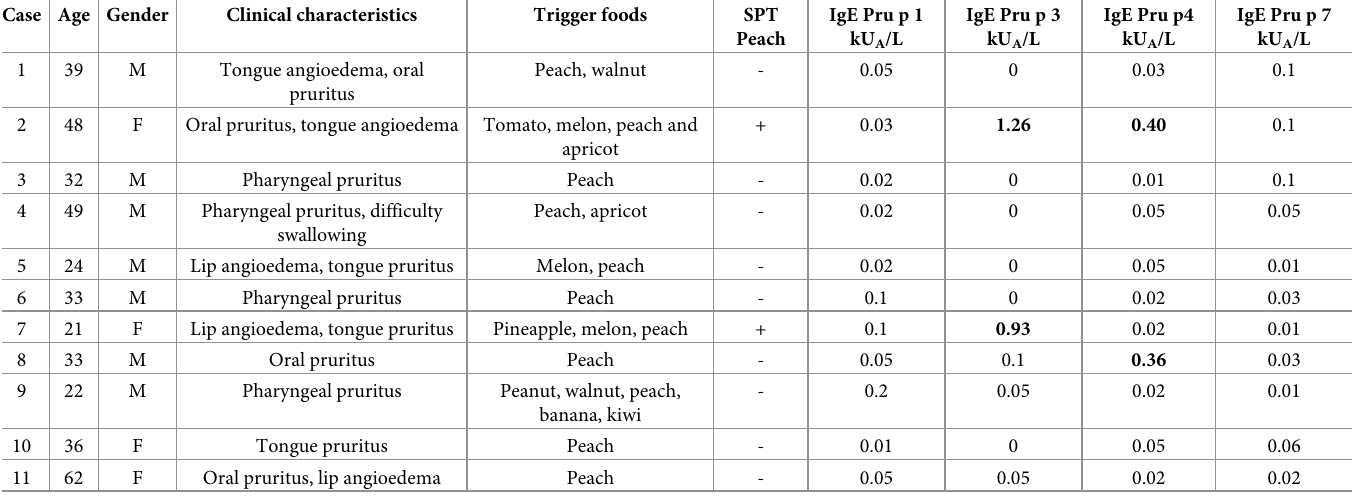
Table 1. Clinical characteristics of patients with OAS due to peach. Case Age Gender Clinical